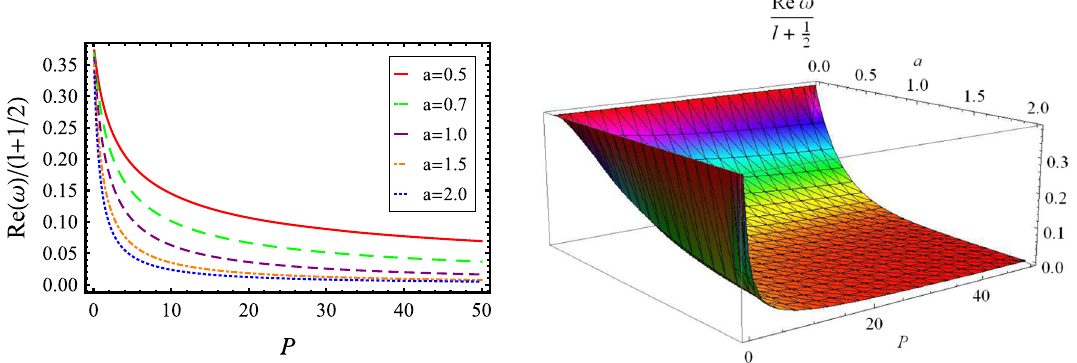
Fig. 2 The dependence (of eikonal limit) of Re (ω)/( l + 1 / 2 ) on P for different a in the range 0 < a ≤ 2. Here we adopt μ = 1 / 2. Left panel: two dimensional plot. Right panel: three dimensional plot